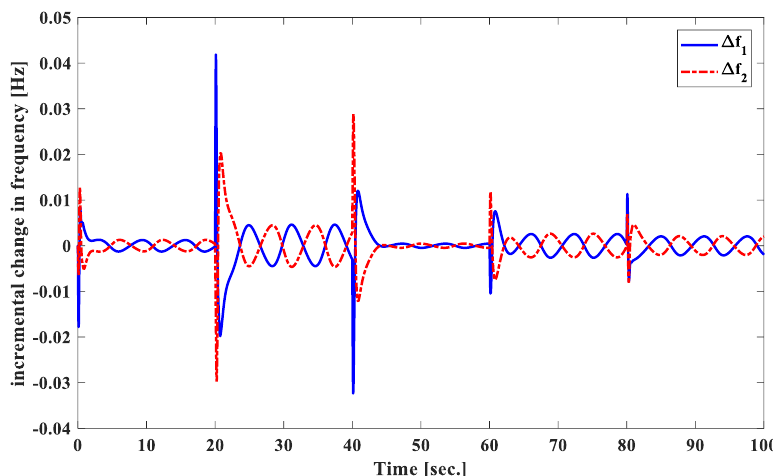
Figure 16. Frequency [Hz] of both control under load variations and the mismatched parameter uncertainties.